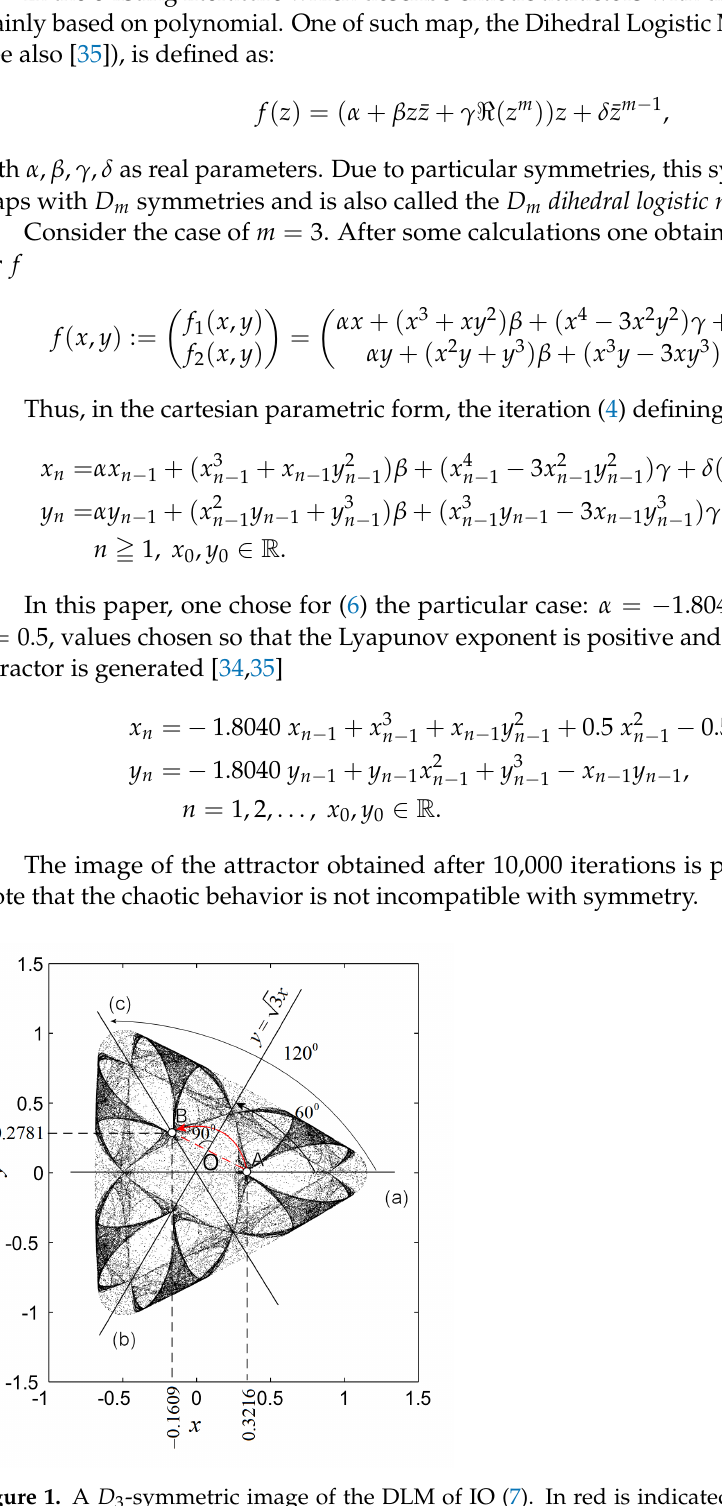
Figure 1. A D 3 -symmetric image of the DLM of IO (7). In red is indicated the counterclockwise rotation with 120 ◦ applied to the point A to obtain the point B which is symmetric with respect the line